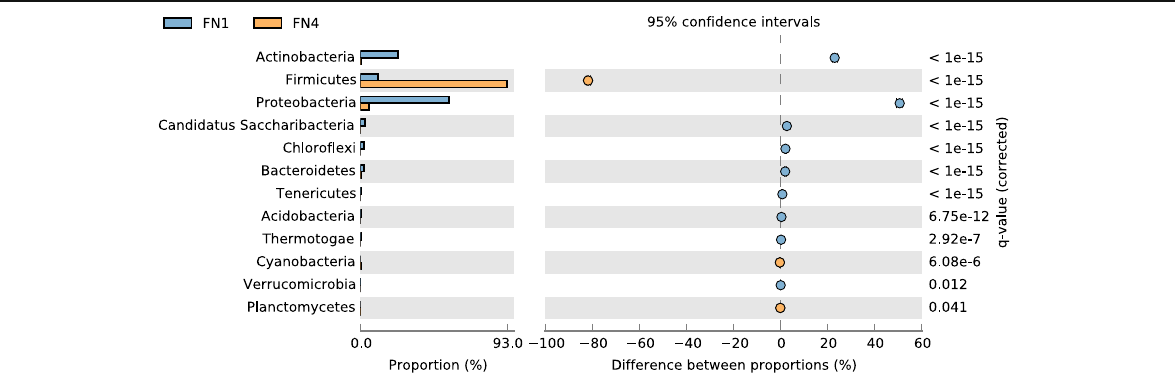
Fig. 1 Comparative taxonomic profile of the FN1 and FN4 metagenomes at the phylum level, computed by Kraken. Only phyla with significant biological differences as determined by STAMP ( P < 0.05, difference between the proportions > 1% and twofold of ratio between the proportions) are shown